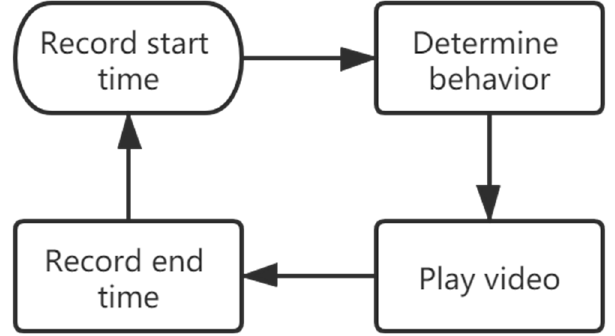
Figure 11. The process of manual record of one grooming behavior.